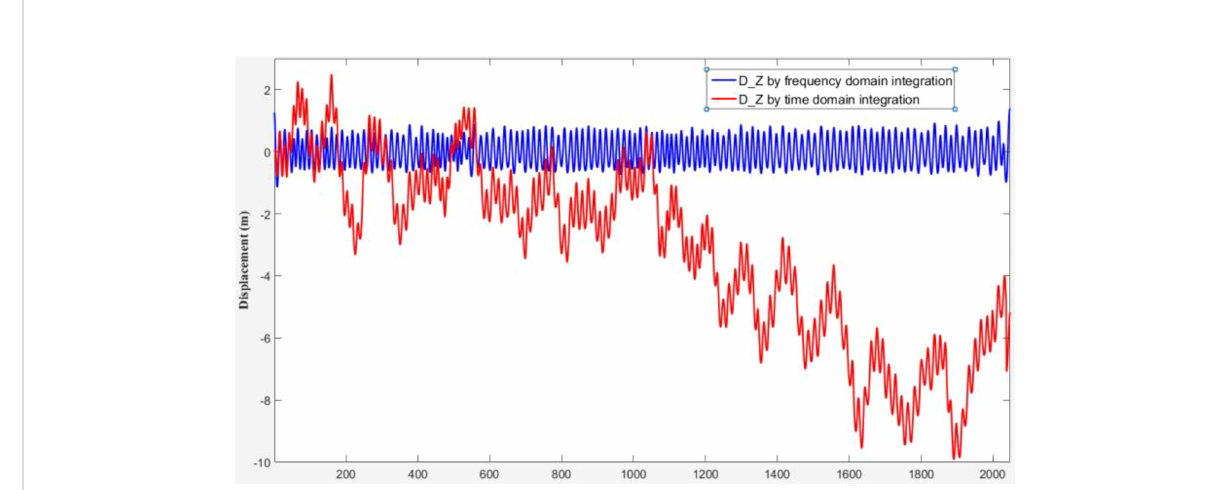
FIGURE 6 Comparison of displacement obtained by time and frequency domain